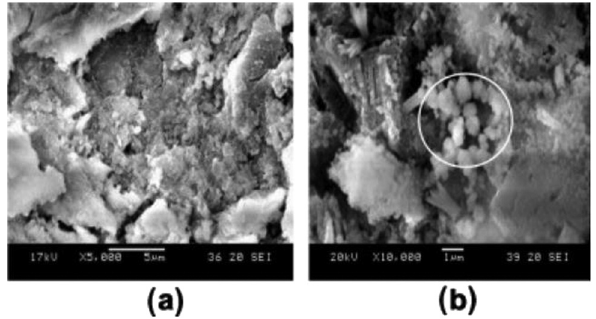
Figure 11: Microstructures for the specimens with ( a ) 0% and ( b ) 1% of nano - SiO 2 added when cured for 7 d [ 110 ] .